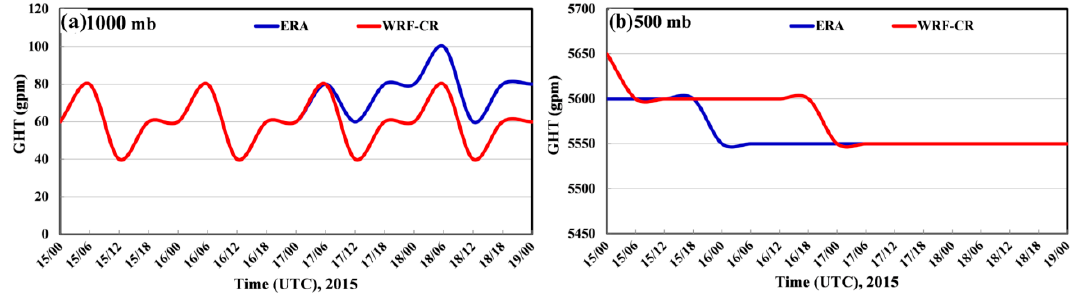
Figure 8. The geopotential height in the trough centers of the WRF-CR and Era-Interim on ( a ) 1000 hPa chart and ( b ) 500 hPa carts during the period 00:00 UTC 15 November until 00:00 UTC 19 November 2015.